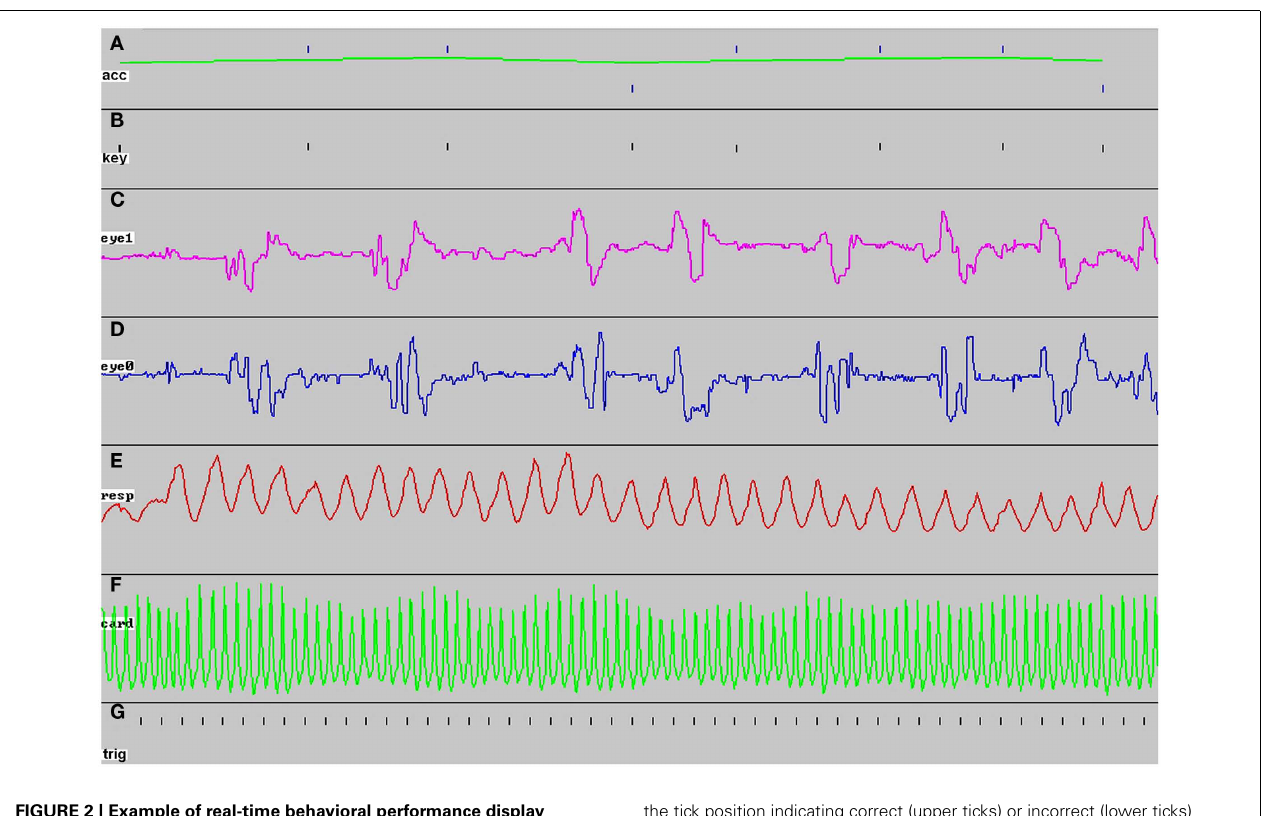
FIGURE 2 | Example of real-time behavioral performance display seen on screen 2 during ObjWM task. The image shows 100s of the task display for a subject scanned at site 3 just before the screen was erased to begin a new sweep [the bold letters (A–G) were added later]. During the scan the display appeared as a continuous sweep in real-time, except for ∼ 1s pauses each time a subject response was expected. At the start of each task, the number of sweep panels displayed was determined and scaled automatically depending on the local hardware and software configuration being used for that scan. (A) Task performance appeared as a tick mark each time the subject was asked to respond, with